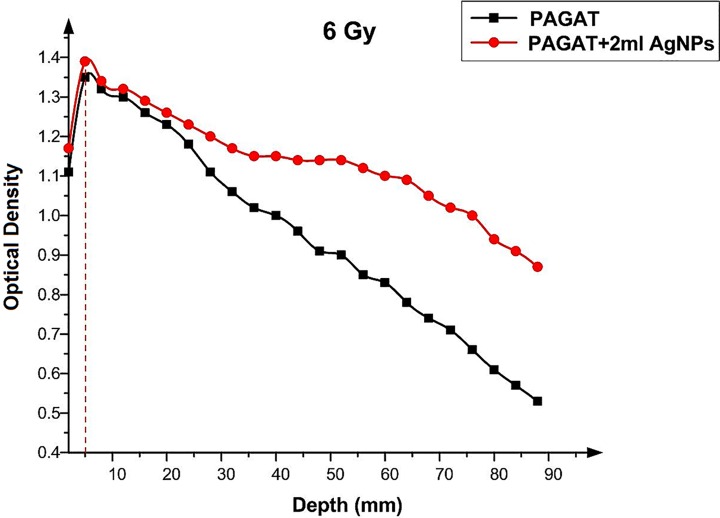
OD versus depth in the PAGAT polymer gel and PAGAT with Ag nanoparticles iraddiated by 6 Gy of 60Co.